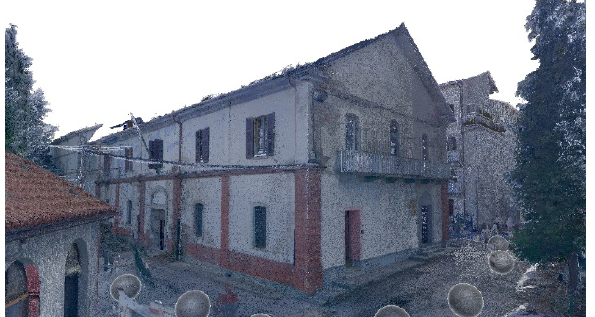
Figure 9. Preview of the scans from BLK360